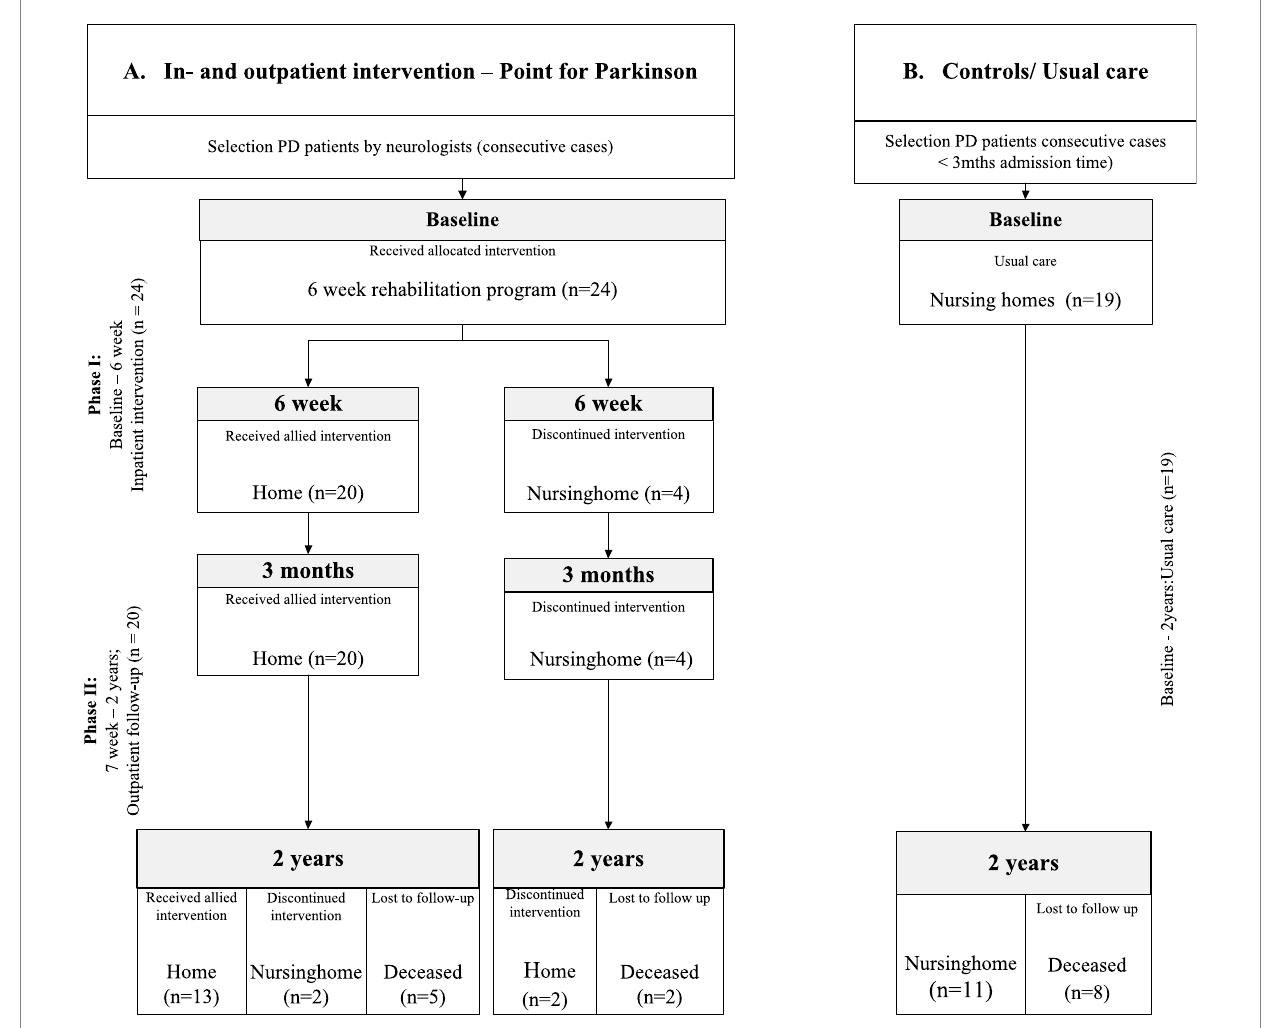
FIGURE 1 Flowchart of the study divided into: Phase I. The inpatient intervention program at the Groningen expertise center (Point for Parkinson, PfP); Phase II. The outpatient follow-up program (Parkinson specialist/neurologist PfP and ParkinsonNet allied health professionals). (A) Intervention Group; who received an inpatient intervention program at the expertise center Point for Parkinson Groningen. (B) Control Group; who were directly admitted to a nursing home and received care as